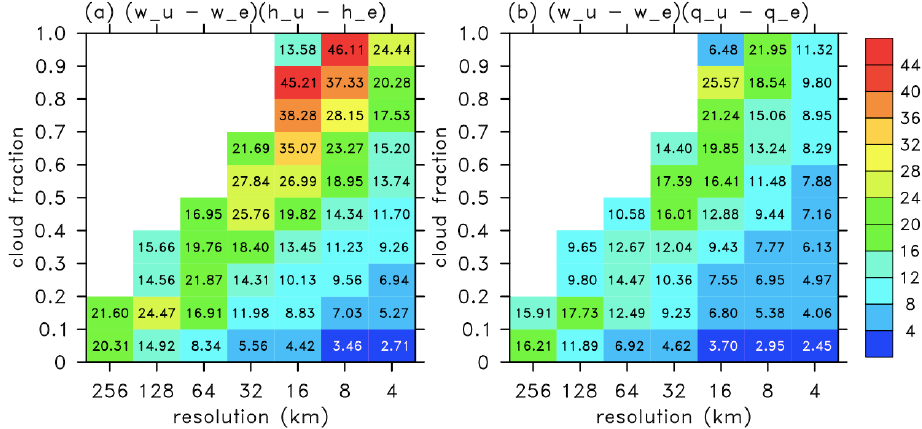
Figure 6. ( a ) ( w u − w e )( h u − h e ) and ( b ) ( w u − w e )( q u − q e ) m/s · K as functions of cloud fraction and ( b ) ( ) as functions of cloud fraction Figure 6. ( a ) and subdomain size at 500 hPa. and subdomain size at 500 ( 𝑤𝑤 𝑢𝑢 − 𝑤𝑤 𝑒𝑒 )( ℎ 𝑢𝑢 − ℎ 𝑒𝑒 ) ( 𝑤𝑤 𝑢𝑢 − 𝑤𝑤 𝑒𝑒 )( 𝐿𝐿 𝑢𝑢 − 𝐿𝐿 𝑒𝑒 ) m/s ∙ K